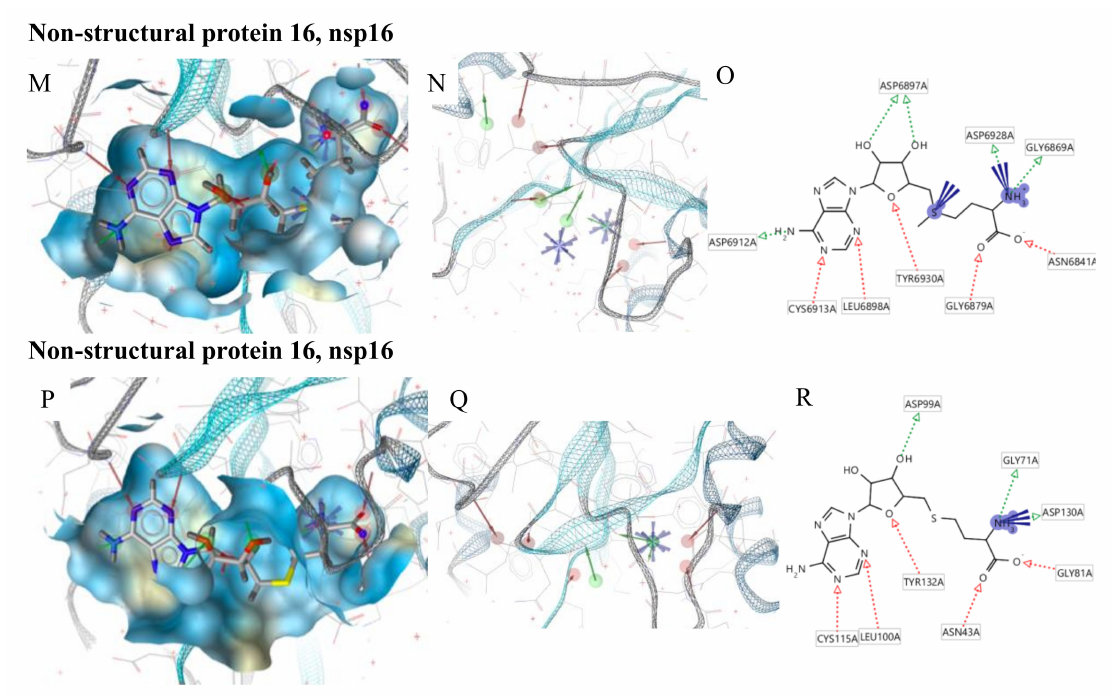
Figure 2. Pharmacophore modeling of ligand–protein complexes. For each structure molecular surface of the active site the co-crystallized ligand ( A , D , G , J , M , P ), structure-based pharmacophore model ( B , E , H , K , N , Q ) and ligand interactions ( C , F , I , L , O , R ) are